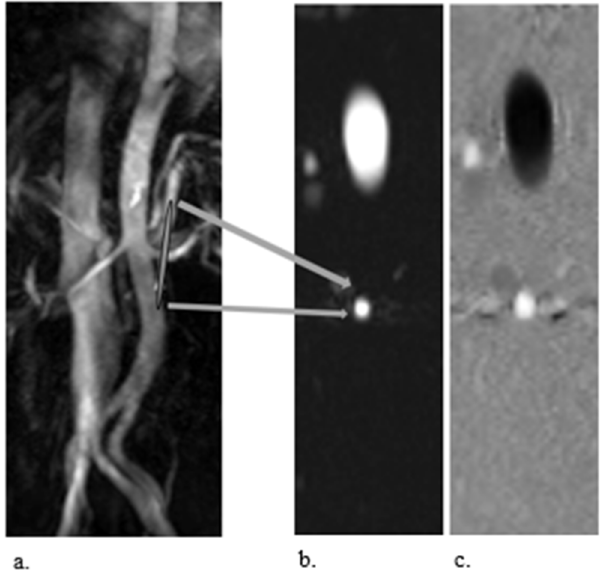
Figure 2. Example of phase–contrast MRI of the left renal artery in a 35-year-old healthy man. ( a ) Shown is a maximum-intensity projection of the entire aorta, used to localise the left renal artery (halfway along the bar). In order to obtain accurate velocities, an exact orthogonal plane of the vessel has to be selected; ( b , c ) show the resulting images of respectively the magnitude of the signal ( b ) and the velocities ( c ) of the left renal artery in a sagittal oblique plane. Post-processing allows quantification of the blood velocity in the vessel by placing ROIs in the lumen of the artery.